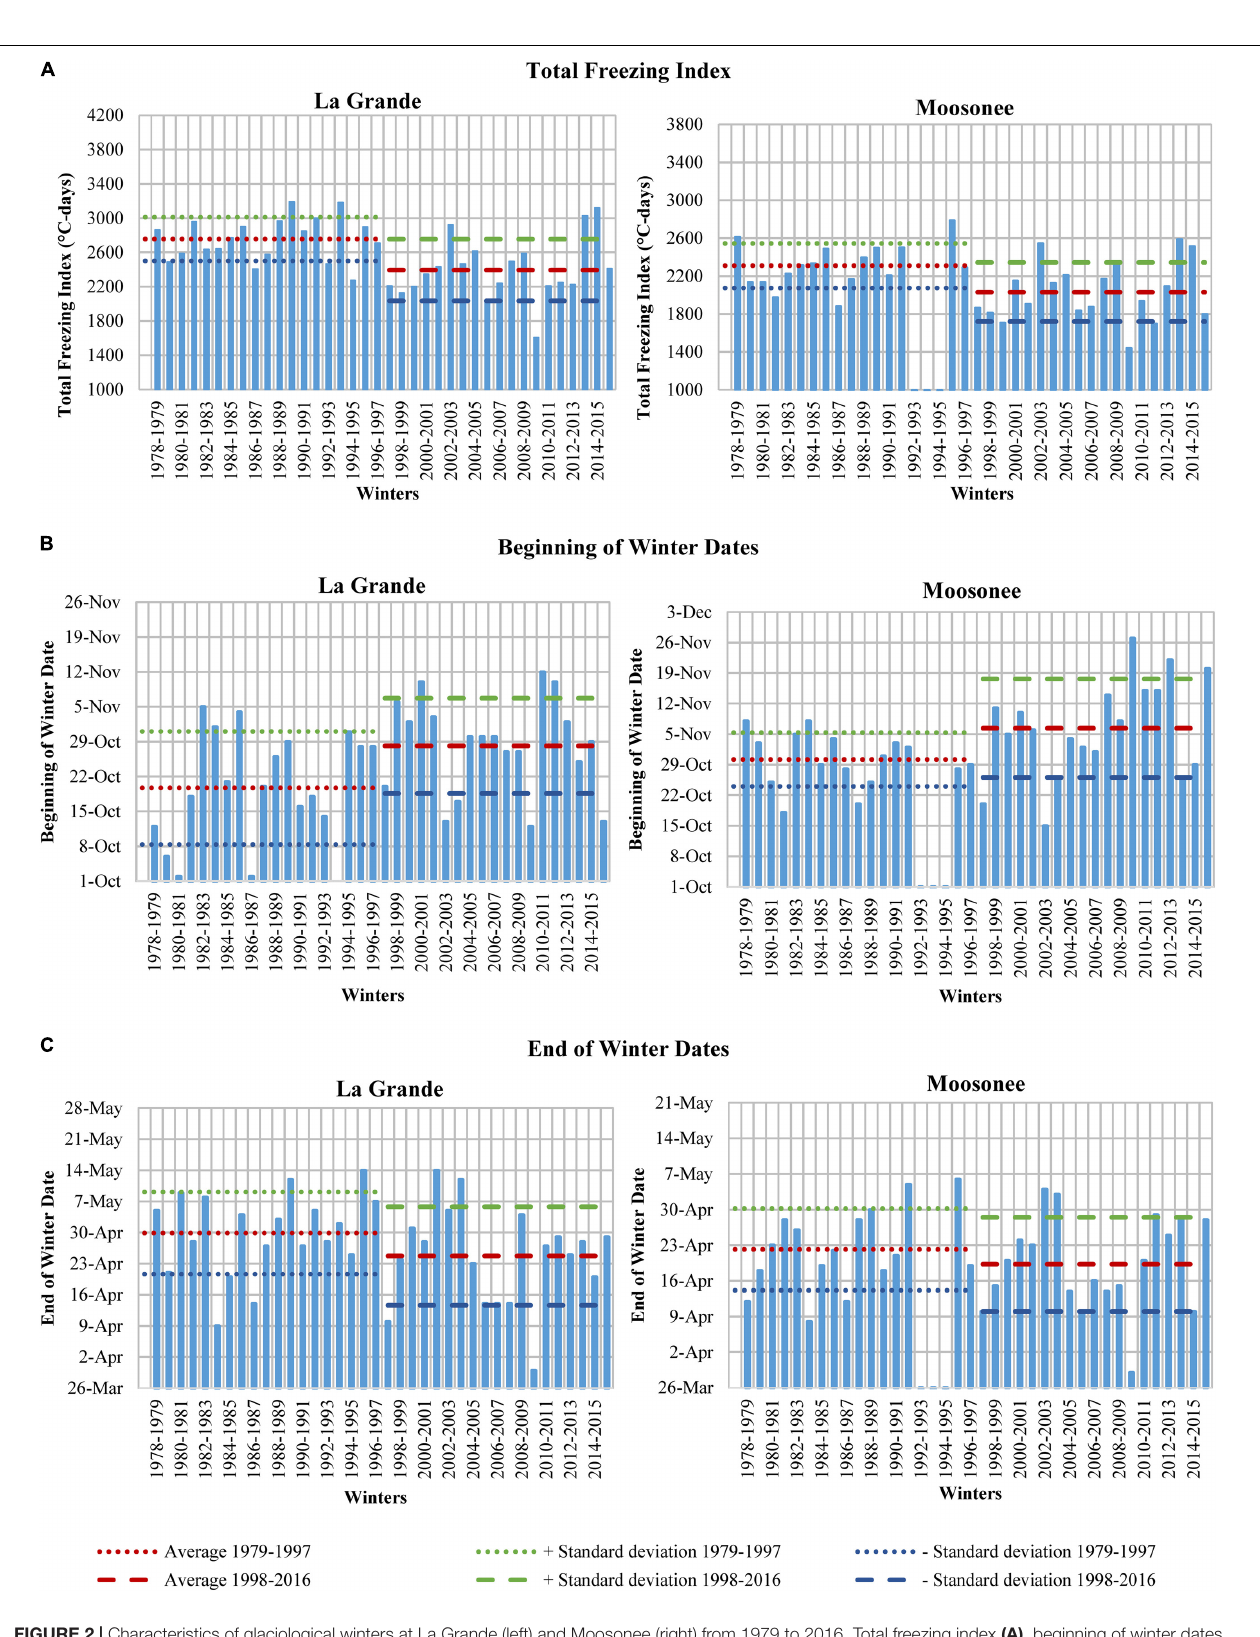
FIGURE 2 | Characteristics of glaciological winters at La Grande (left) and Moosonee (right) from 1979 to 2016. Total freezing index (A) , beginning of winter dates (B) , and end of winter dates (C) adapted from Taha et al. (2017).